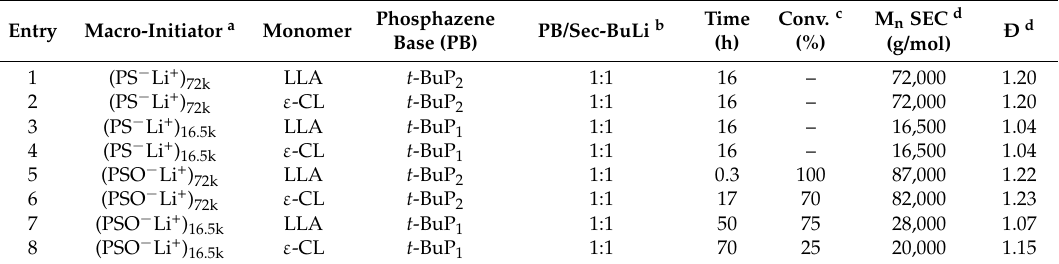
Figure 6. ( A ) SEC traces obtained from withdrawn aliquots at different time intervals during the [ t -BuP 1 ]/[ sec -BuLi]:1/1 polymerization of butadiene; ( B , C ) Relationship between number-average molecular weight (black line) and polydispersity (blue line) vs monomer conversion during the 1:1 [ t -BuP 2 ]/[ sec -BuLi] and [ t -BuP 1 ]/[ sec -BuLi], polymerization of butadiene, respectively; ( D ) Relationship between number-average molecular weight (black line) and polydispersity (blue line) vs. monomer conversion during the polymerization of 1,3-butadiene in the absence of phosphazene superbase. Table 2. Sequential copolymerization of ε -caprolactone and L-lactide using the “living”